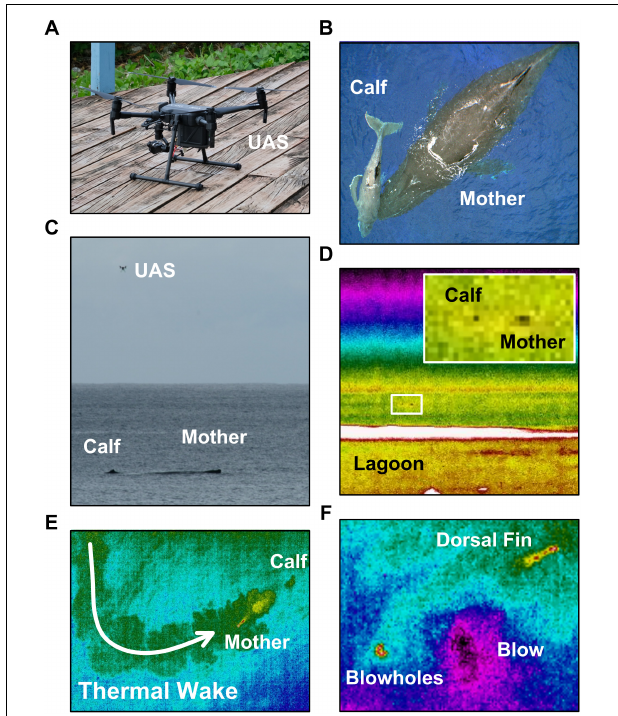
FIGURE 1 | Visible and infrared spectrum images of: the DJI Matrice 200 unoccupied aerial system (UAS; i.e., drone) used in this study (A) ; 20 m altitude aerial visible spectrum image of a logging mother-calf humpback whale pair (B) ; shore-based Fujifilm XT2 visible spectrum image of the humpback calf, its mother, and the UAS taken with a 200 mm telephoto lens (C) ; shore-based FLIR A615 infrared spectrum image of the humpback whale mother-calf pair (D) ; 20 m altitude aerial Zenmuse XT infrared spectrum image of the mother-calf pair’s thermal wake and mother’s dorsal fin (E) ; 20 m altitude aerial Zenmuse XT infrared spectrum image of the mother blowholes, blow spout, and dorsal fin (F)